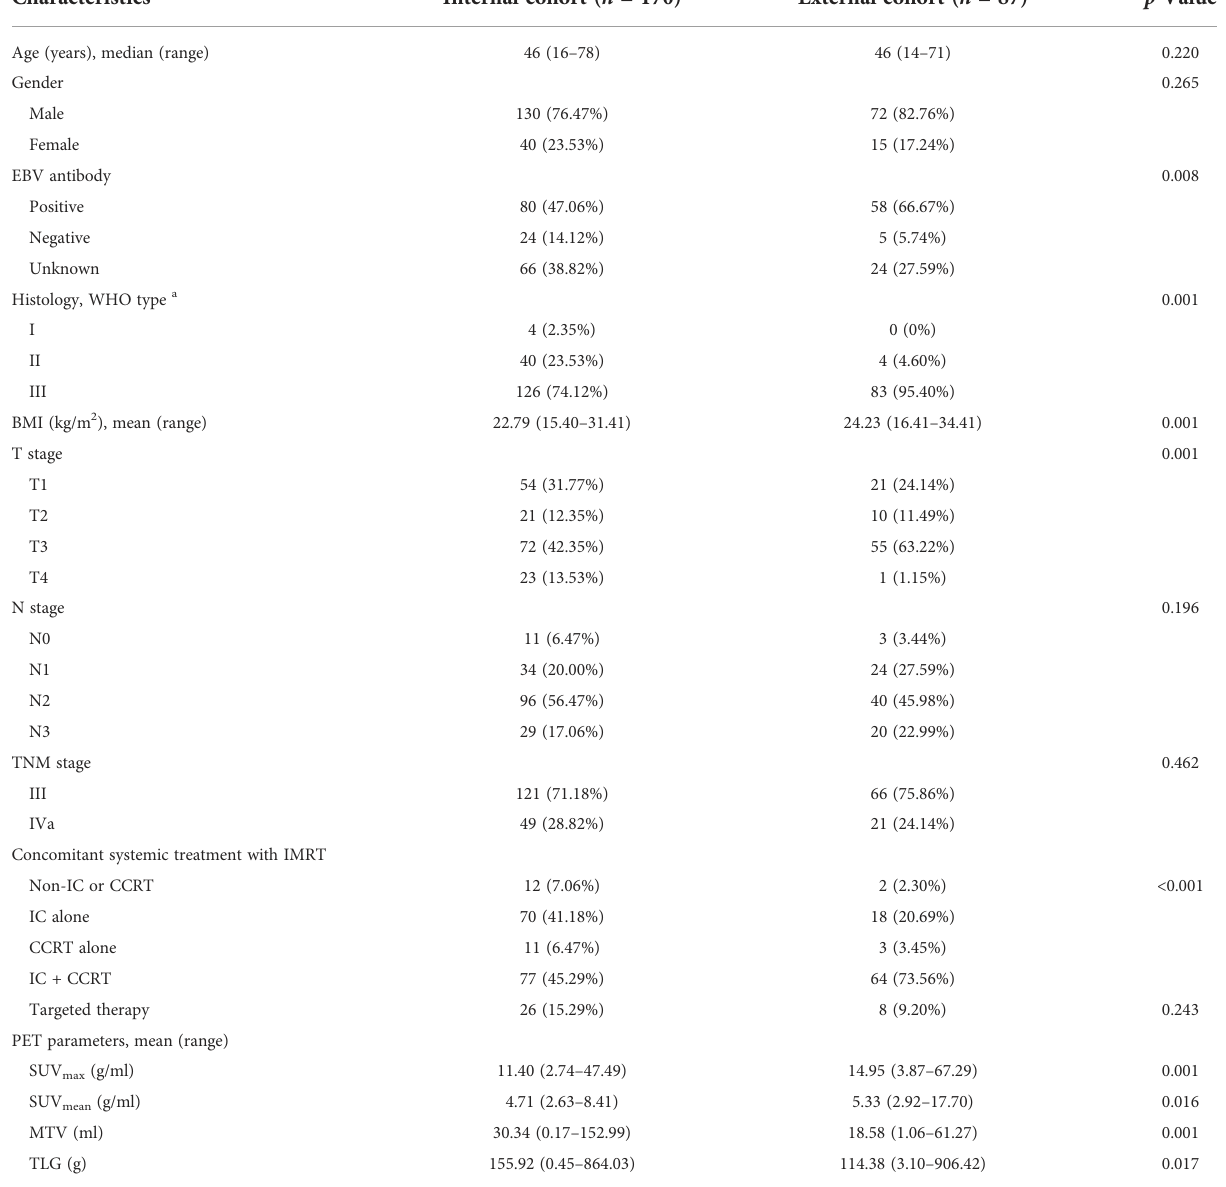
TABLE 1 Patient characteristics in the internal and external